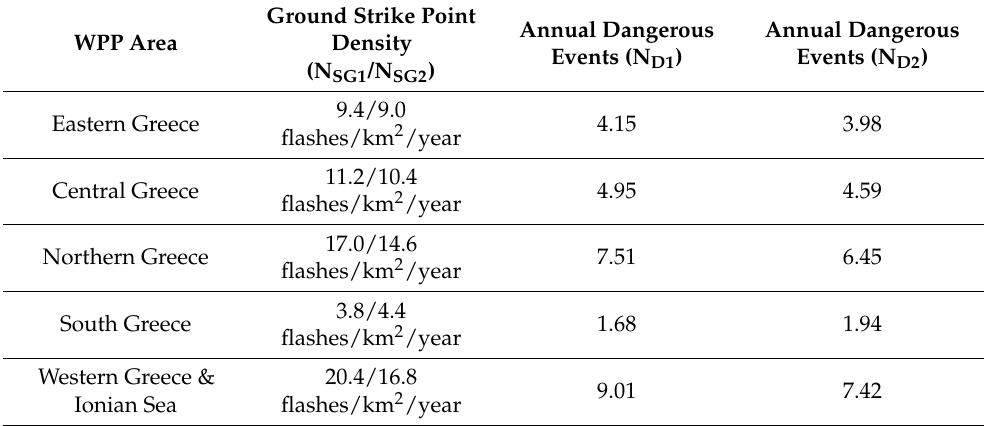
Table 4. Calculation of lightning ground strike point and average annual dangerous